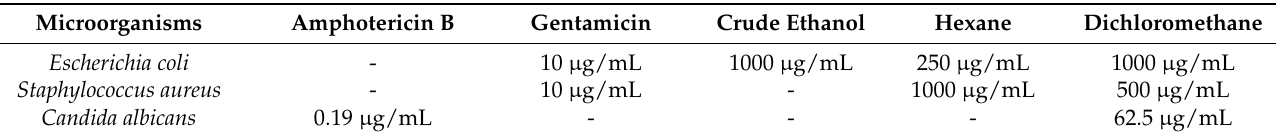
Table 3. Antimicrobial activity of crude ethanol extracts and its fractions (non-volatile component). Microorganisms Amphotericin B Gentamicin Crude Ethanol Hexane Dichloromethane Escherichia coli - 10 µ g/mL 1000 µ g/mL 250 µ g/mL 1000 µ g/mL Staphylococcus aureus - 10 µ g/mL - 1000 µ g/mL 500 µ g/mL Candida albicans 0.19 µ